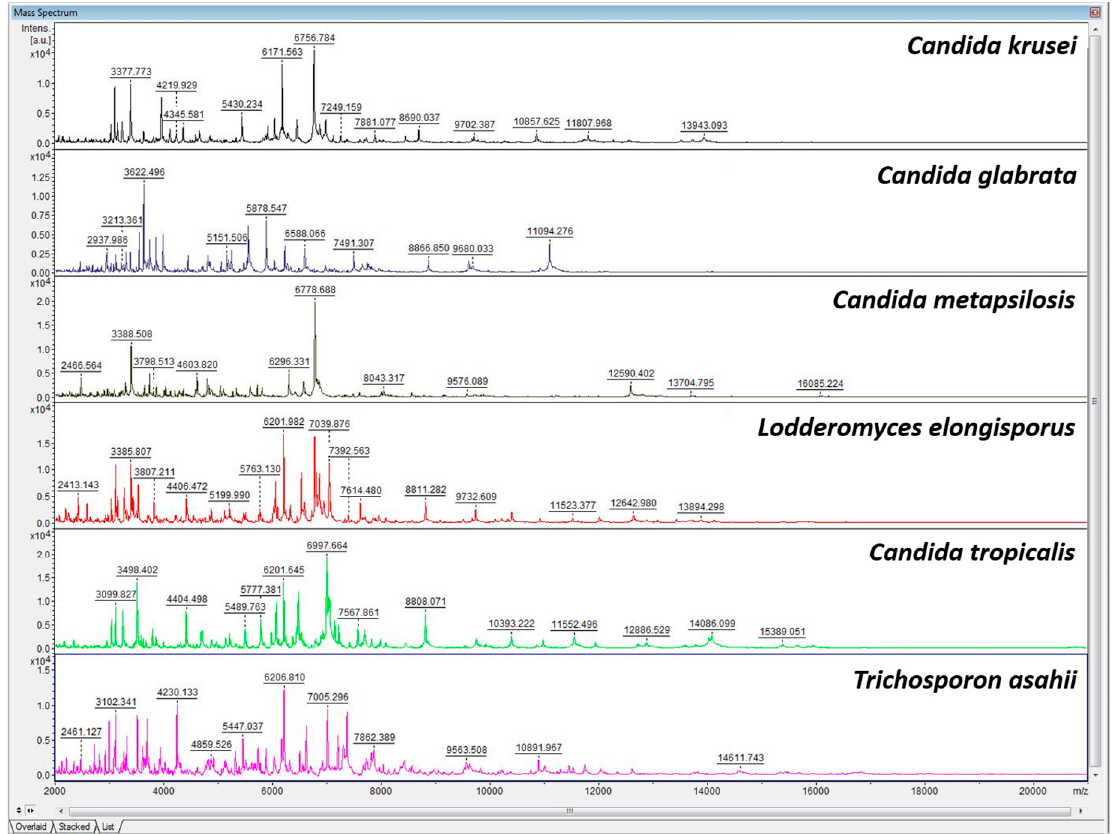
Figure 1. Representative spectra profiles of six common yeast species colonized in pigeon droppings.